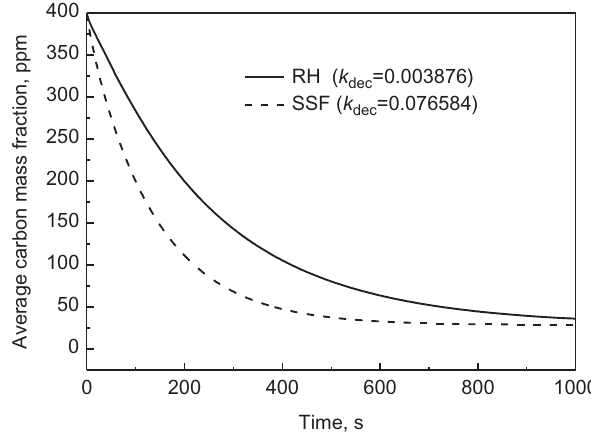
Figure 4: Variation of average carbon mass fraction with